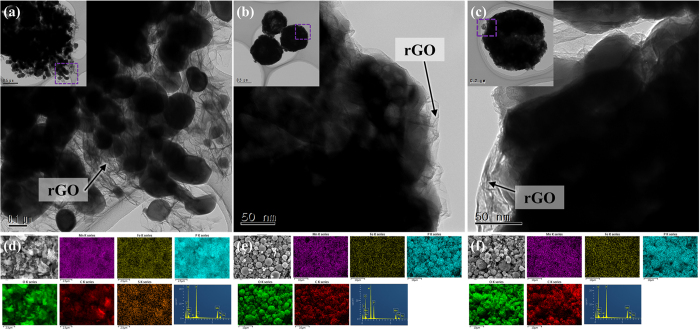
TEM images of 3D LiMn0.75Fe0.25PO4/rGO microspheres synthesized using different metal salts: (a) SO4_LMFP, (b) NO3_LMFP, and (c) Cl2_LMFP. Energy-dispersive X-ray spectroscopy (EDS) elemental maps of the 3D LiMn0.75Fe0.25PO4/rGO microspheres: (d) SO4_LMFP, (e) NO3_LMFP, and (f) Cl2_LMFP.